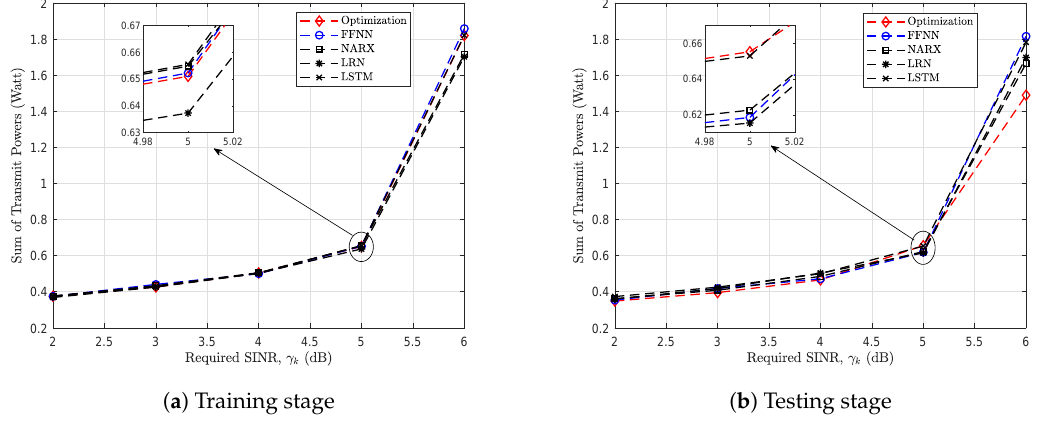
Figure 7. Sum of transmit powers according to the required SINR when the required harvested energy is given by − 20 dBm ( e k = − 20 dBm).